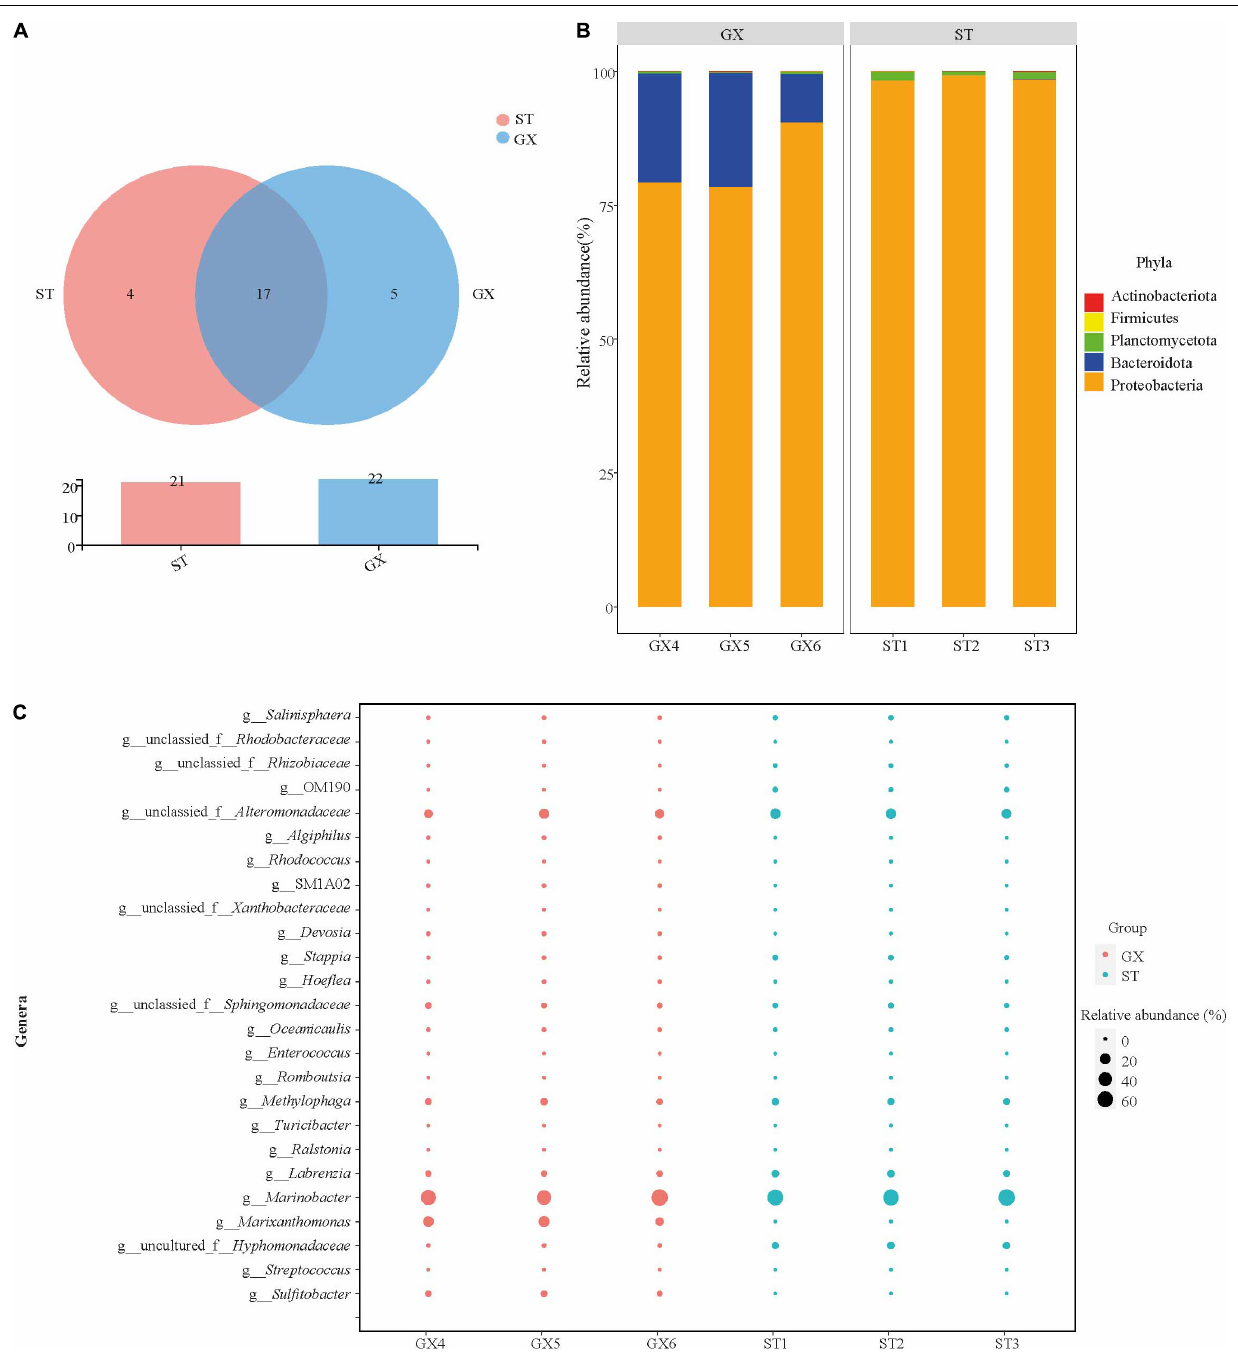
FIGURE 2 | Composition of Phaeocystis globosa bacterial communities. (A) Shared and unique OTUs among co-cultures, visualized with Venn diagrams. (B) Co-culture bacterial community composition at the phylum level. (C) Co-culture bacterial community composition at the genus level. GX, P . globosa GX strain co-culture; ST, P . globosa ST strain